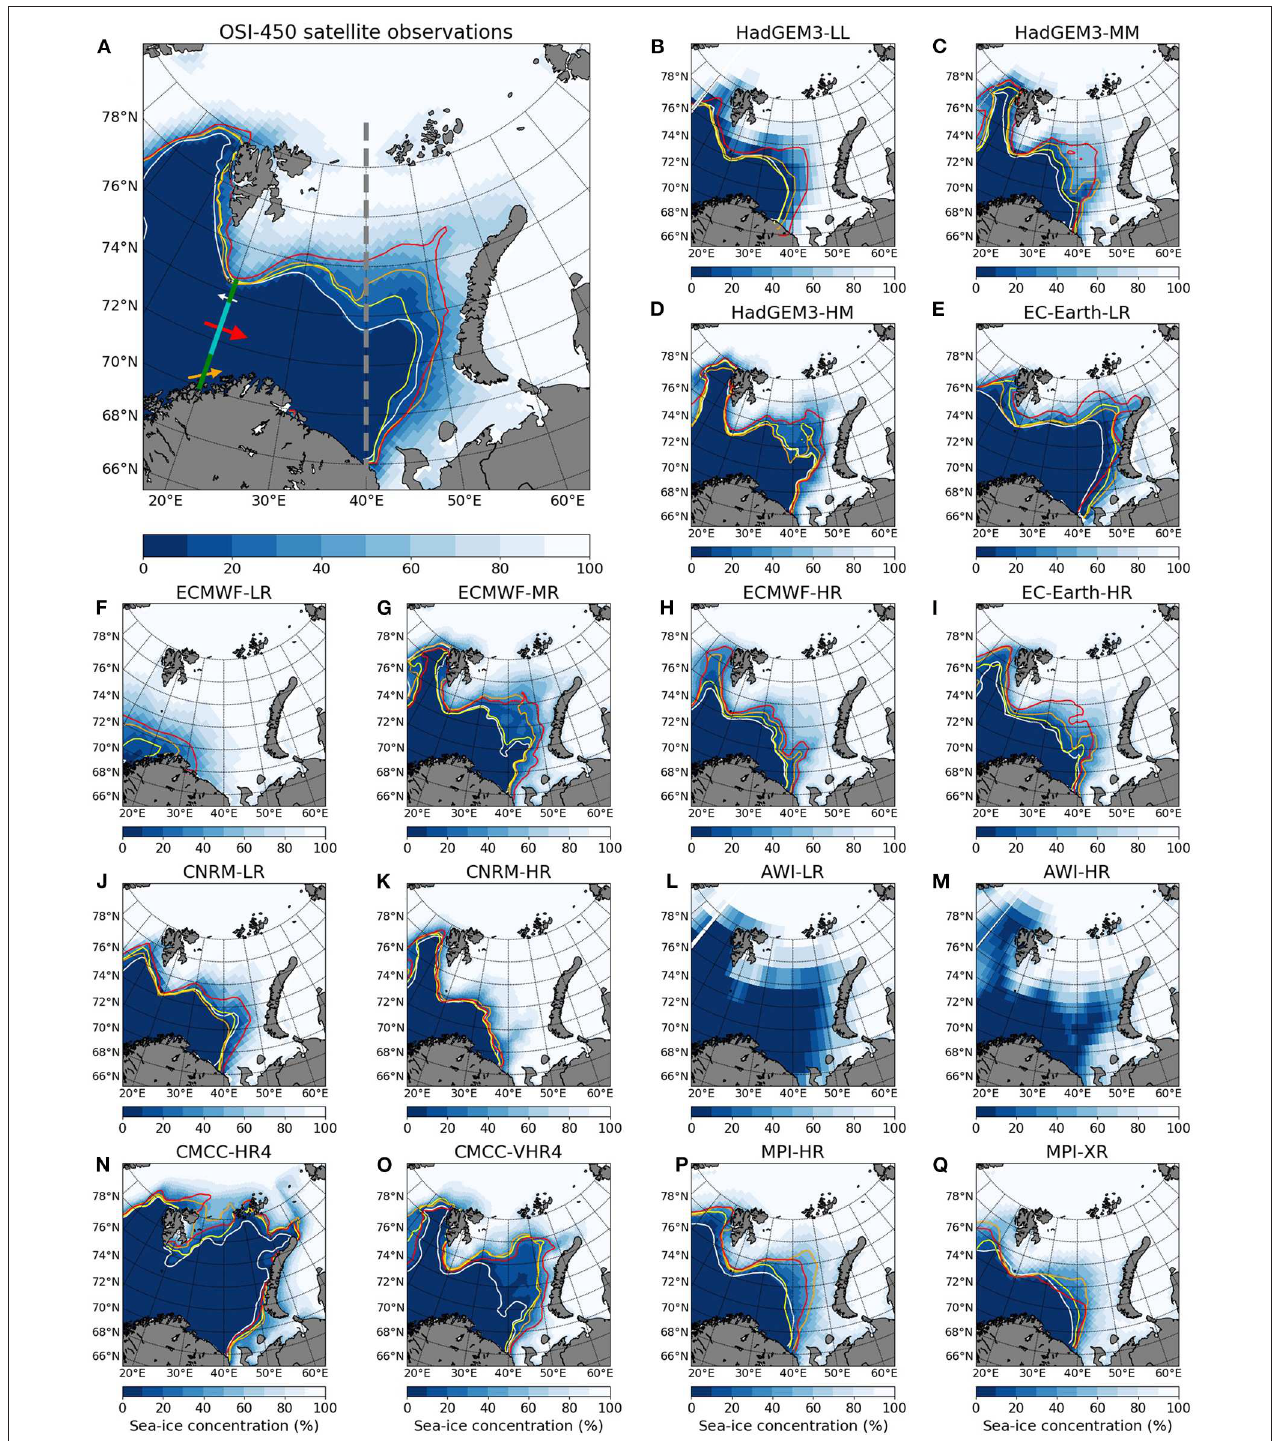
FIGURE 1 | March sea-ice concentration in the Barents Sea from (A) OSI-450 satellite observations and (B–Q) HighResMIP hist-1950 model outputs, averaged over 1979–2014. The white, yellow, orange, and red contours show the mean March sea-ice edge (where sea-ice concentration is 15 % ) in 1980–1989, 1990–1999, 2000–2009, and 2010–2014, respectively. In (A) , the green meridional transect (20 ◦ E, 70–74.5 ◦ N) shows the “large” Barents Sea Opening (BSO); the cyan meridional transect (20 ◦ E, 71.5–73.5 ◦ N) shows the “reduced” BSO (Atlantic Water contribution only); the dashed gray transect (40 ◦ E, 67.5–82 ◦ N) is the transect used in Figure 12 ; the red, orange, and white arrows represent the Atlantic Water inflow, Norwegian Coastal Current inflow, and Bear Island Trough outflow through the BSO, respectively.